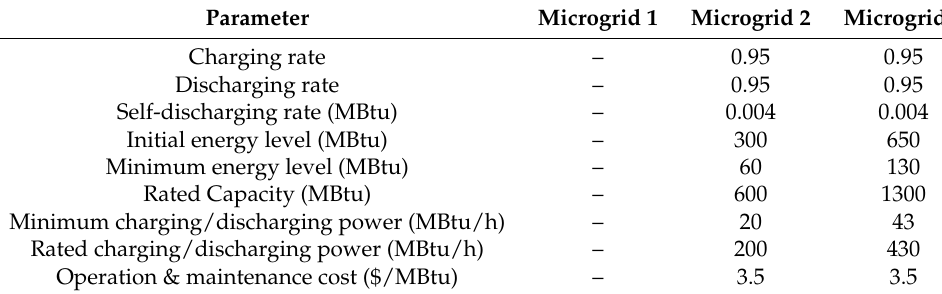
Table 3. TS parameters. – : Not